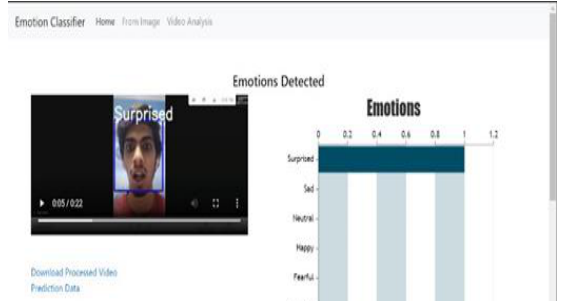
Fig. 9. Emotions detected in image.